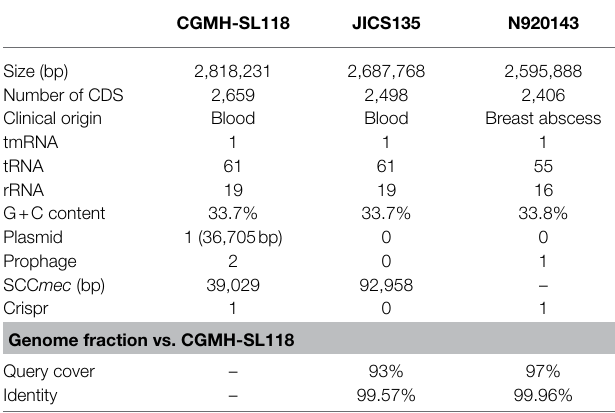
TABLE 2 | Basic information of CGMH-SL118 whole-genome sequence analysis and comparison with other reference